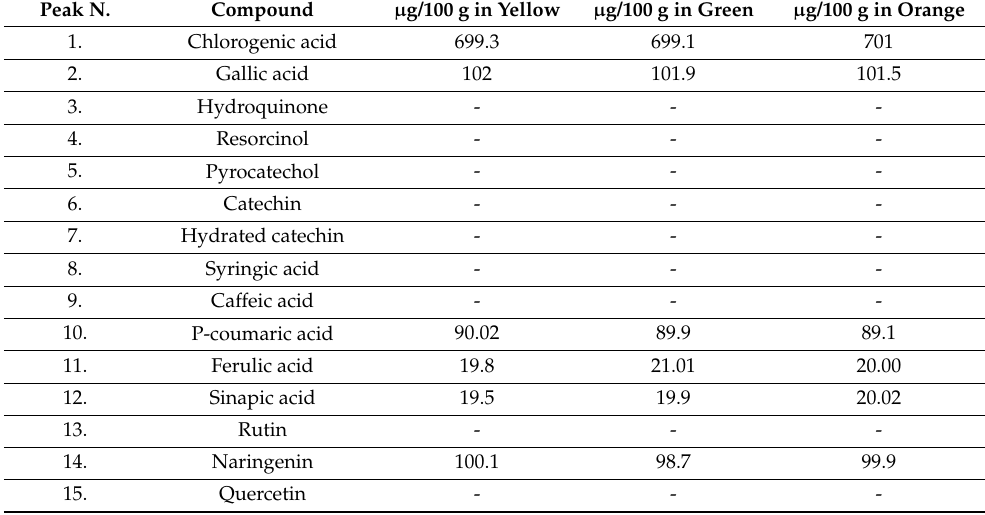
Table 4. Identification of different constituents of Opuntia ficus-indica seed extracts in different plant cultivars from the Souk Ahras area, Northeast